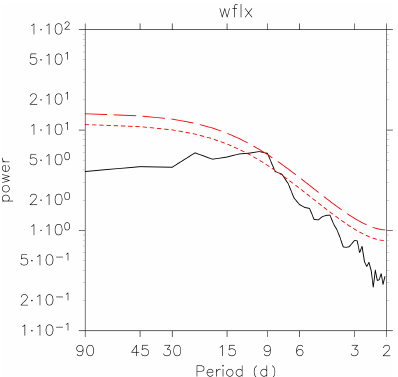
Figure 6. Power spectrum of the longitudinal flux of thickness- weighted low-PV area at 60 ◦ E at the 370K level, calculated for June–August and averaged over 1979–2016. Broken red curves rep- resent 95% and 99% confidence